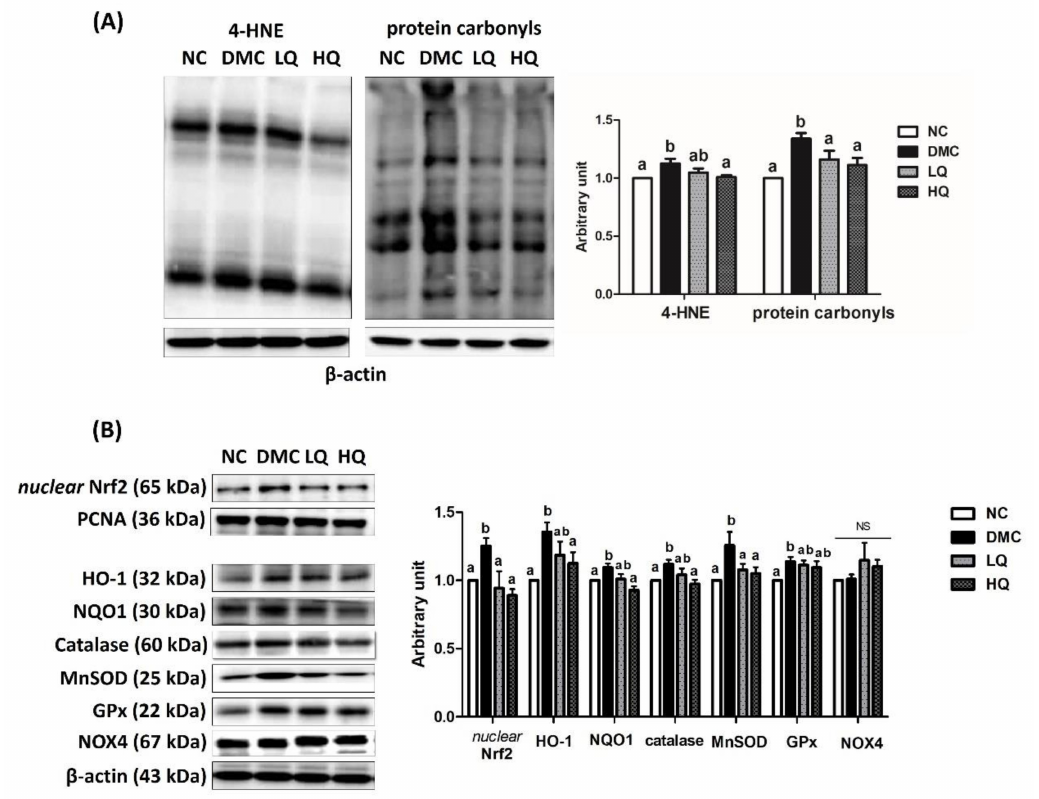
Figure 3. E ff ect of QAE on renal ( A ) 4-hydroxynonenal (4-HNE) and protein carbonyls and ( B ) antioxidant defense system in T2DM mice. Data were expressed as means ± SEM. Mean values with the same superscript letter (a,b) are not significantly di ff erent ( p < 0.05). NC: Normal mice; DMC: Type 2 diabetic mice; LQ: Type 2 diabetic mice supplemented with a low dose (5 mg / kg / day) of QAE; HQ: Type 2 diabetic mice supplemented with a high dose (10 mg / kg / day) of